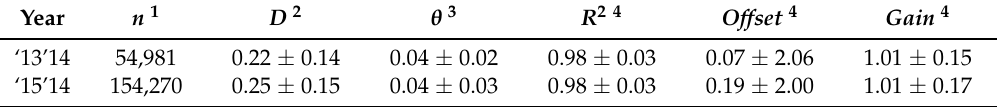
Table 6. Difference indicators and linear correlation results after calibration.